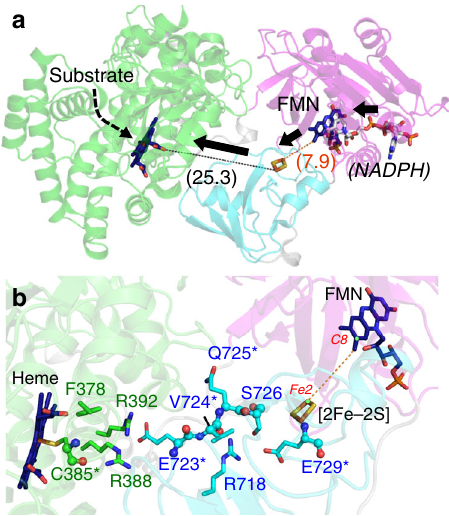
Fig. 2 Intramolecular electron transfer pathway. a The CYP116B46 structure is presented as in Fig. 1. The NADPH modeled from pea FNR is displayed as white stick. The thick arrows indicate the direction of electron transfer and the dashed arrow represents the putative portal for substrate entry. Dashed lines connect the redox centers observed in the structure and the corresponding distances (in Å) are also indicated. Black and orange dashed lines represent edge-to-edge distance between heme and [2Fe-2S] cluster and [2Fe-2S] cluster and FMN, respectively. b A close-up view of ( a ). The electron transfer path between the C8 methyl group of FMN and the Fe2 of [2Fe-2S] cluster is indicated by a dashed line. The protein residues that may constitute the long-range electron transfer path between [2Fe-2S] and heme are shown as sticks. Residues that may contribute both main chain and side chain to the electron delivery path are noted by asterisks and their main chains are displayed as spheres. Residues colored in green and cyan belong to the heme and ferredoxin domain, respectively. The orange dashed line indicates the distance between FMN C8 methyl group and [2Fe-2S] cluster Fe2